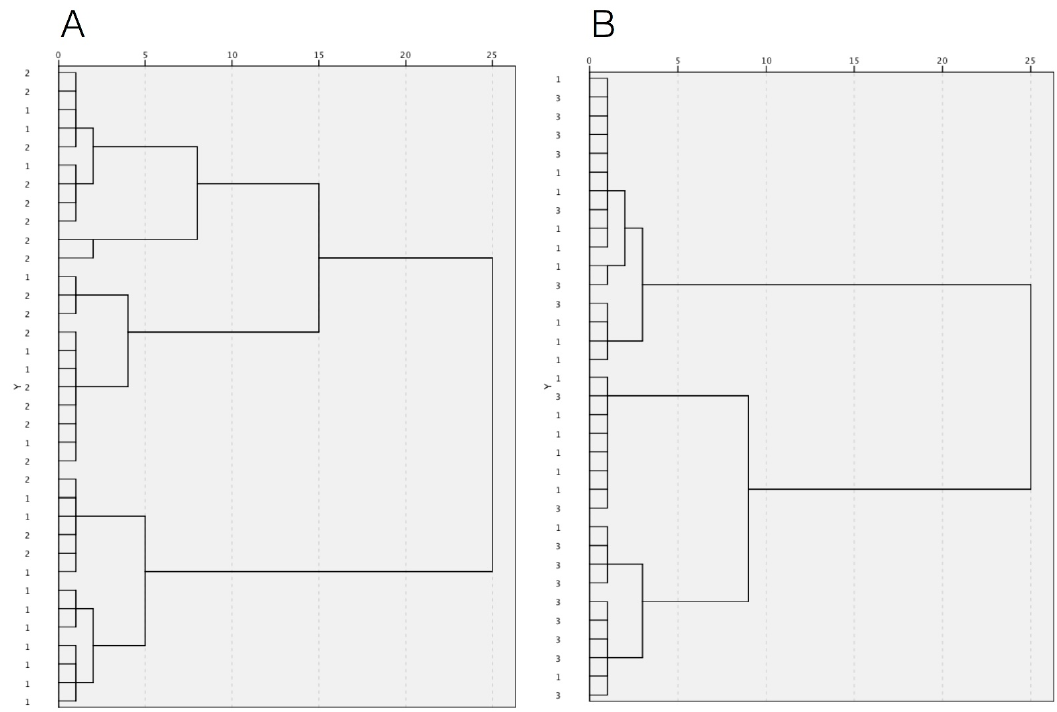
Figure 2. The dendrograms show the results of HCA based on ion distribution in unstimulated whole saliva: ( A ) clustering of subjects with untreated severe periodontitis (group 2) and periodontally healthy controls (group 1); ( B ) clustering of subjects with treated severe periodontitis (group 3) and periodontally healthy controls (group 1).